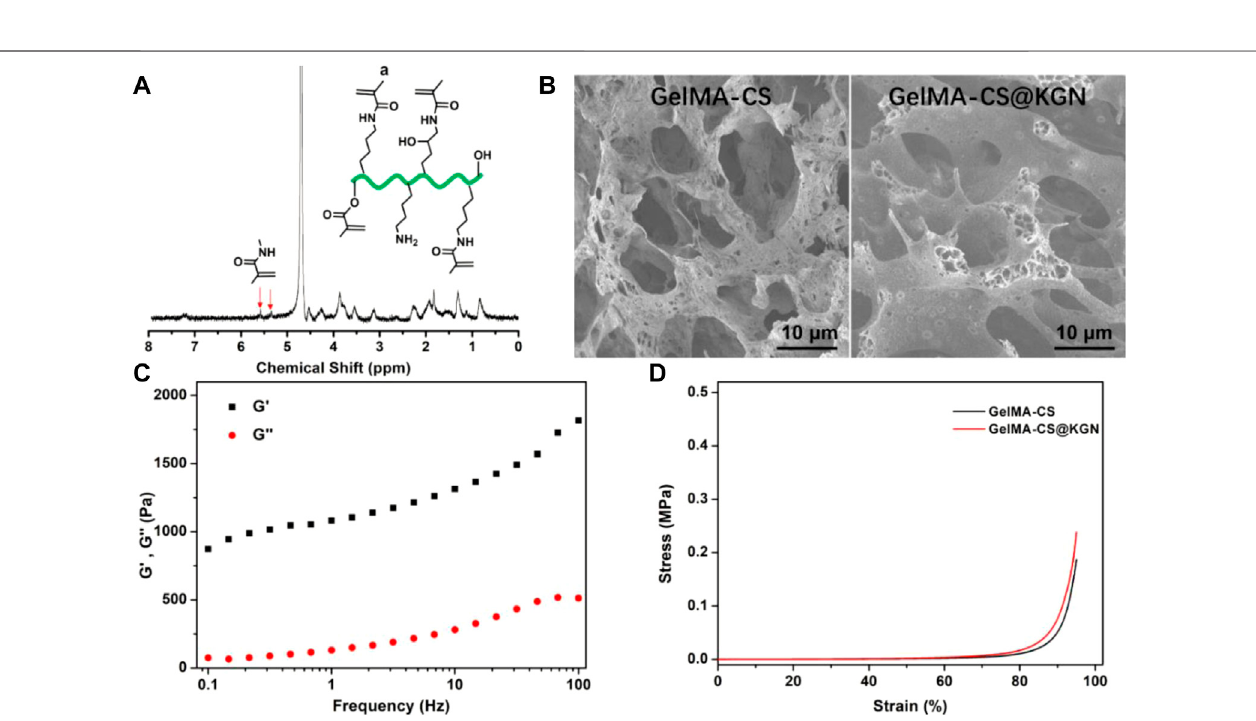
FIGURE 2 | (A) 1 H NMR spectrum of GelMA. (B) SEM images of GelMA-CS and GelMA-CS@KGN hydrogels. (C) Rheology of the GelMA-CS. (D) Compressive curves of GelMA-CS hydrogels with or without KGN laden.